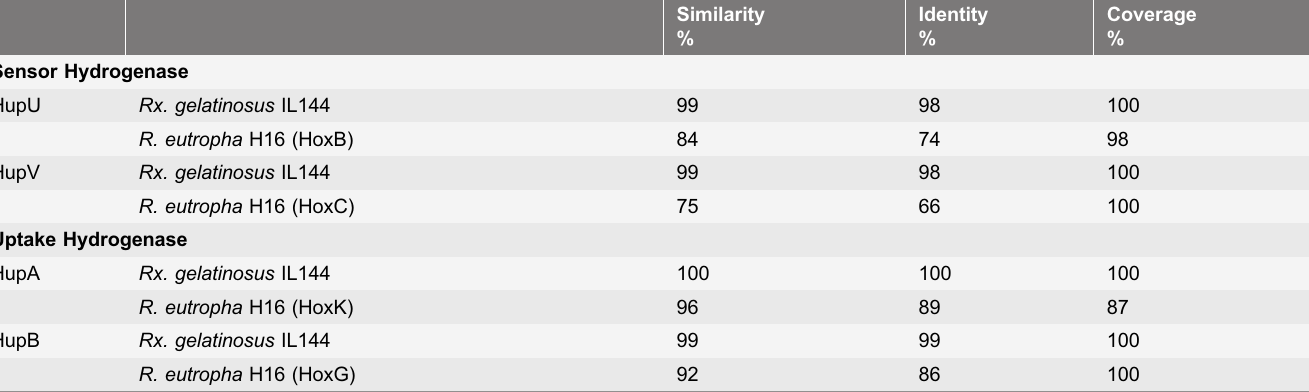
Table 2. Similarity, identity, and coverage of select hydrogenase proteins comparing the Rubrivivax gelatinosus CBS sensor and uptake hydrogenases to other bacterial species including Ralstonia eutropha H16.